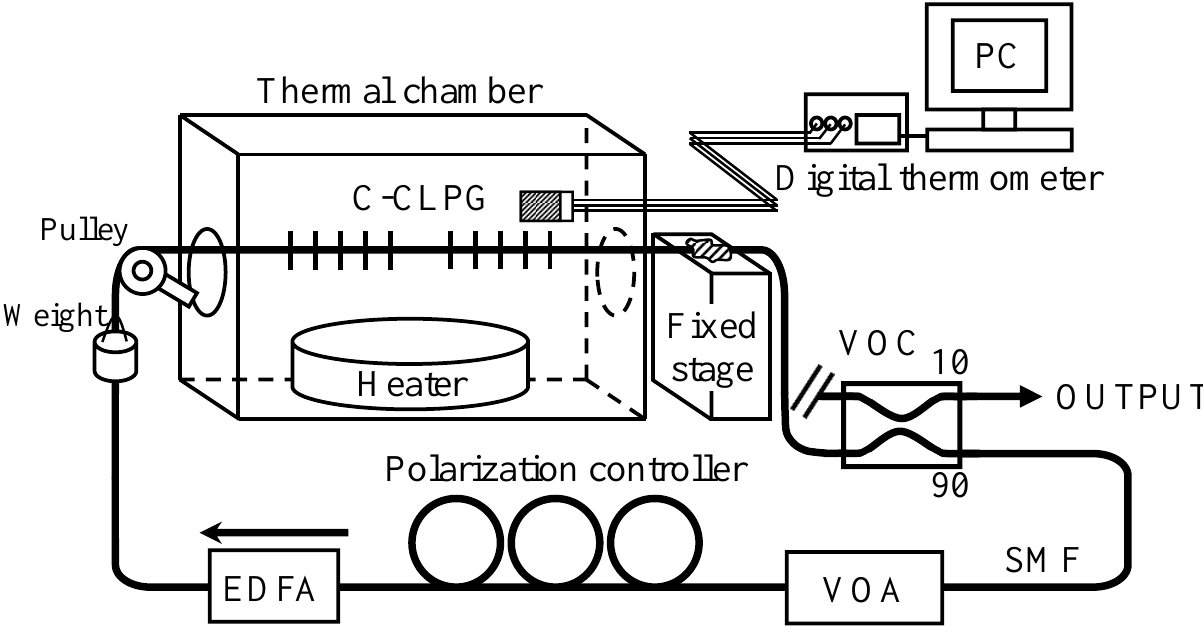
Figure 1. Experimental setup for the tunable and switchable EDFRL using C-CLPG.